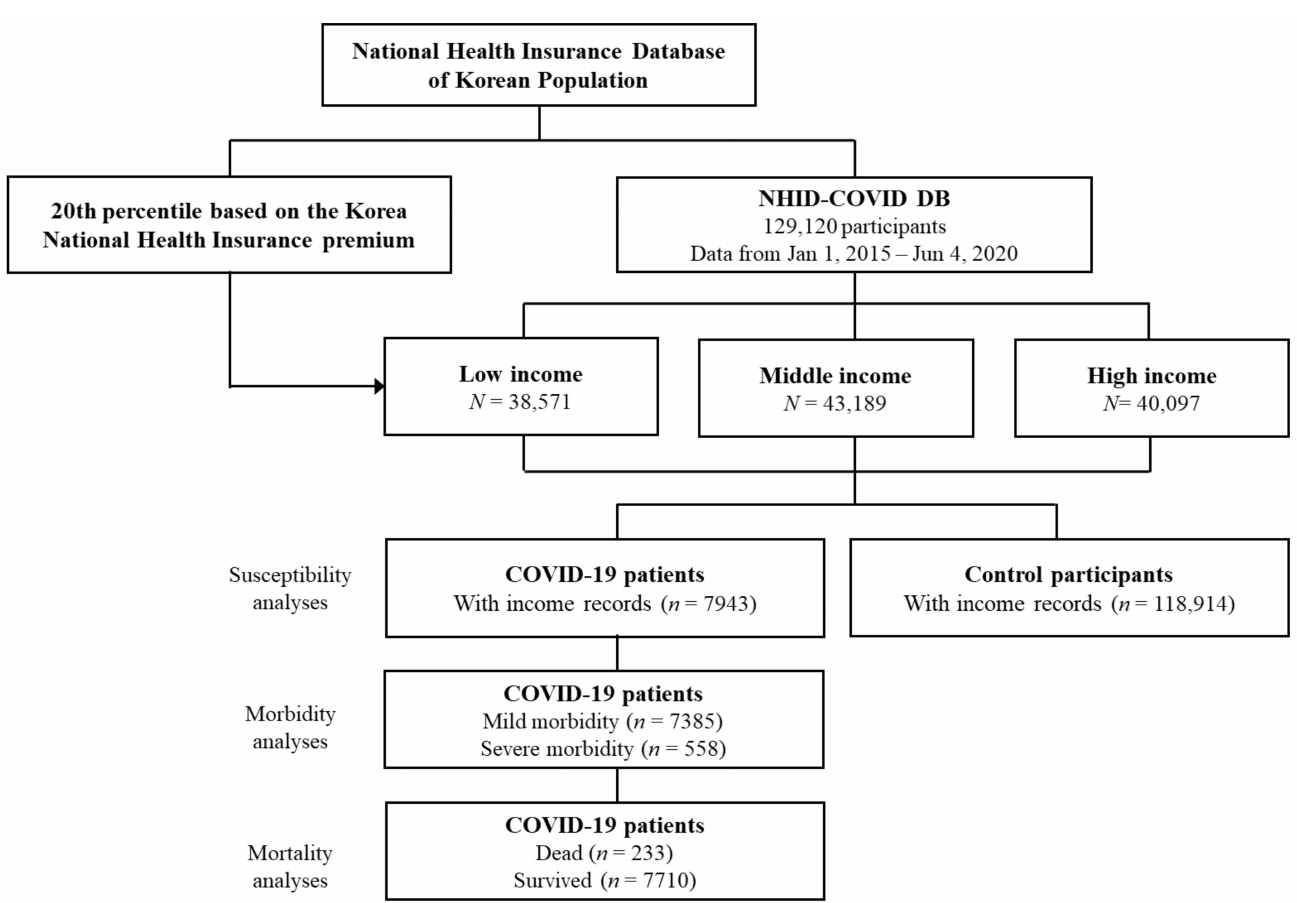
Figure 1. A schematic illustration of the participant selection process that was used in the present study. Of a total of 129,120 participants, 7943 COVID-19 patients and 118,914 control participants were